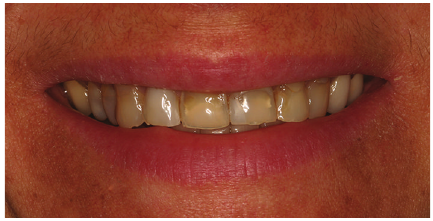
Figure 1: Clinical view of the smile.